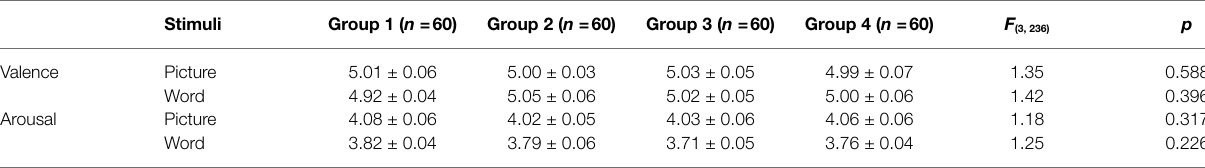
TABLE 1 | The average valence and arousal ratings of the stimuli groups in this study. Stimuli